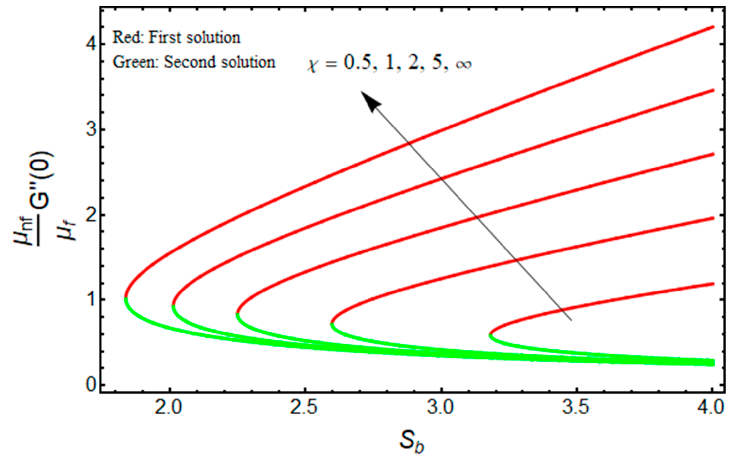
( ( (cid:17) (cid:16) ( χ χ on G (cid:48)(cid:48) ( 0 ) versus S b when φ = 0.025, M b = 0.5. Figure 8. Effect of χ on µ nf / µ f on